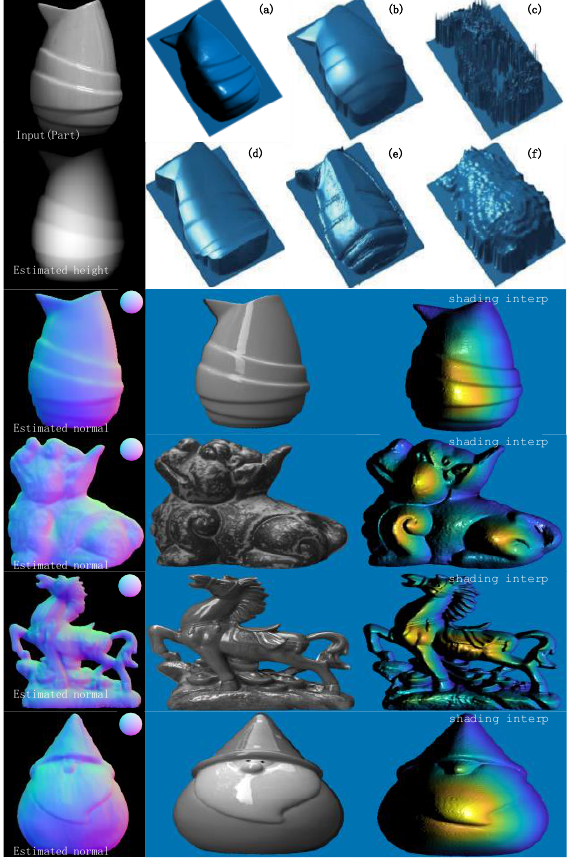
Figure 15. Sample of the rest of the reconstruction results. (a) Ours; (b) Reference [13]; (c) Multiple perspectives; (d) Reference [22]; (e) Reference [23]; (f) Rough depth.